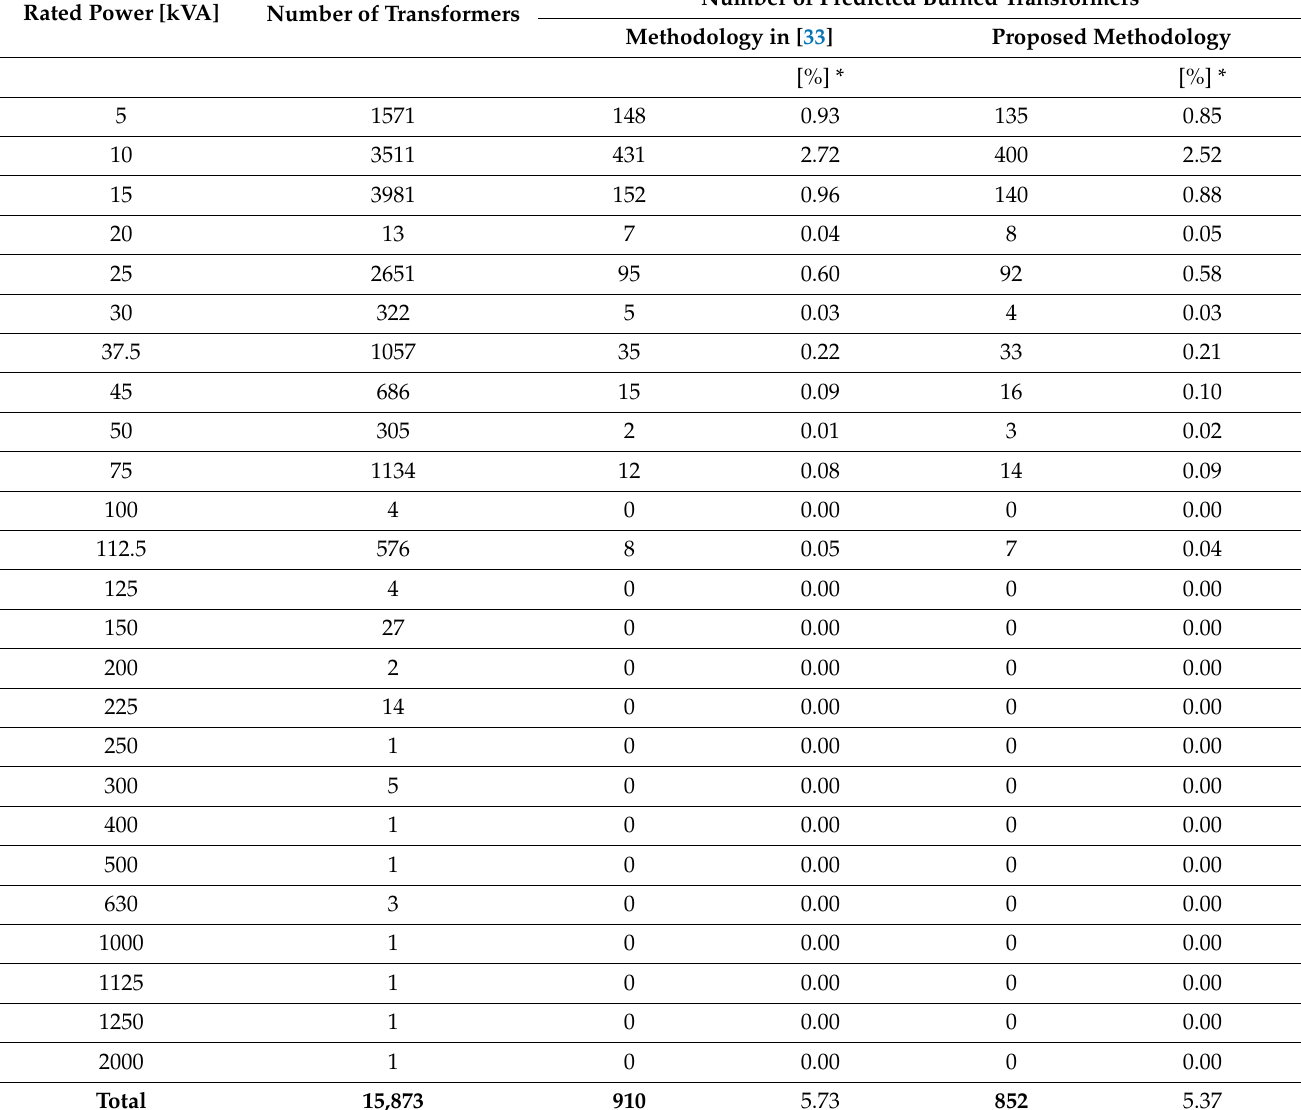
Table 3. Transformer data and predicted burned transformers during 2021 for both the methodology in [33] and the proposed